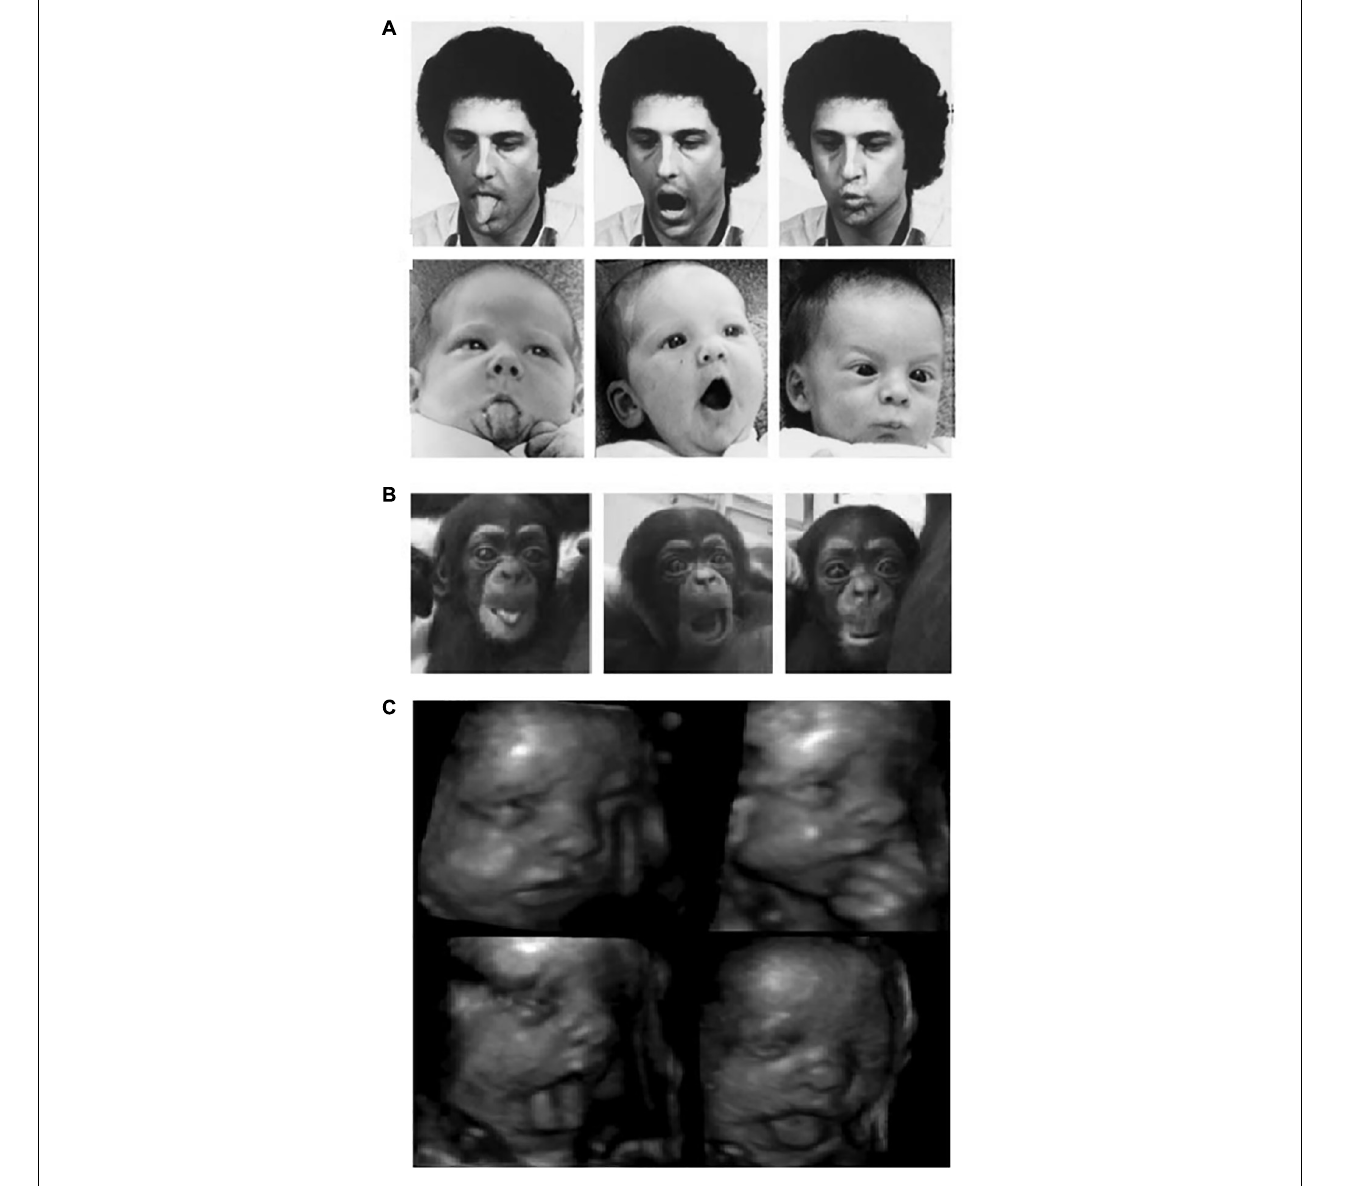
FIGURE 1 | (A) Human and (B) chimpanzee neonates imitating orofacial gestures (left panel: tongue protrusion; middle panel: mouth-opening; right panel: lips protrusion) [ (A) Reprinted with permission from Meltzoff and Moore (1977) and (B) Reprinted with permission from Myowa-Yamakoshi et al. (2004)]. (C) A twenty-eight-week gestational age fetus producing aerodigestive stereotypies Reprinted with permission from Kurjak et al.